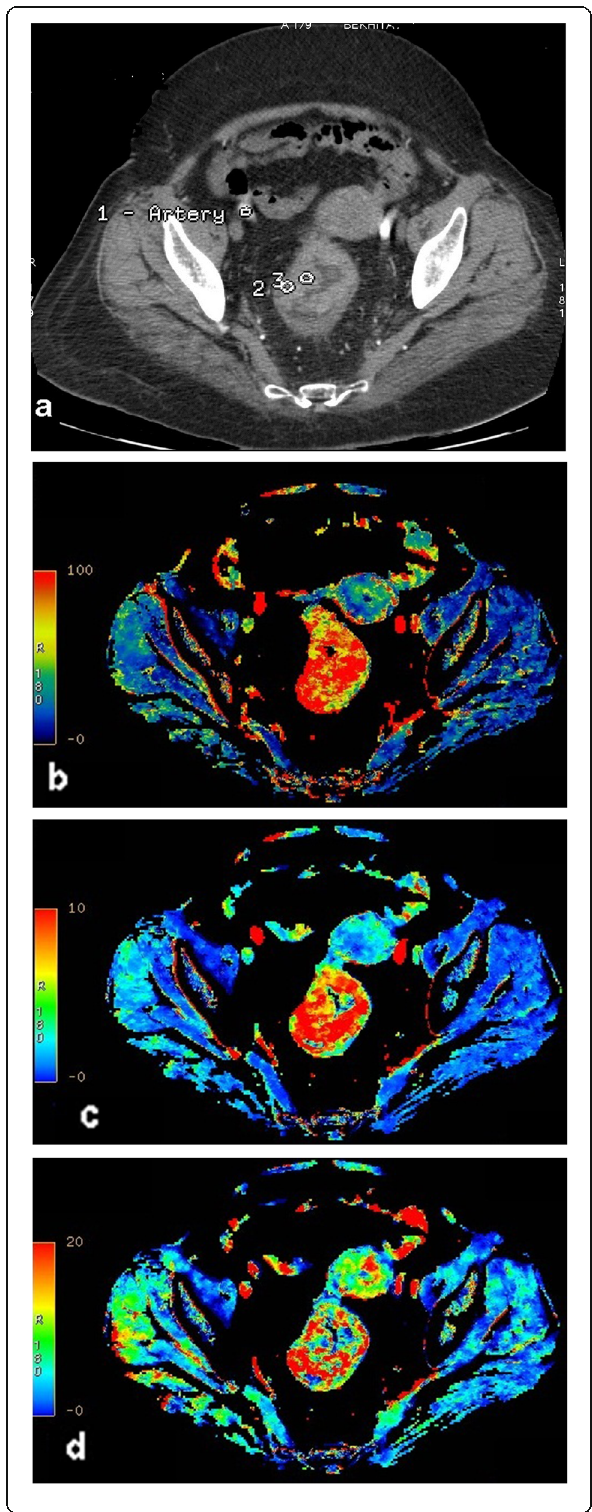
Fig. 2 A 53-year-old women with moderately differentiated cancer of the sigmoid colon. a CT image shows the location of the ROIs; ROI 1 = 20 mm 2 in the artery, ROI 2 = 30 mm 2 at the edge of the tumor, ROI 3 =30 mm 2 at the center of the tumor. Corresponding parametric color maps ( b – d ); b blood flow, c blood volume,